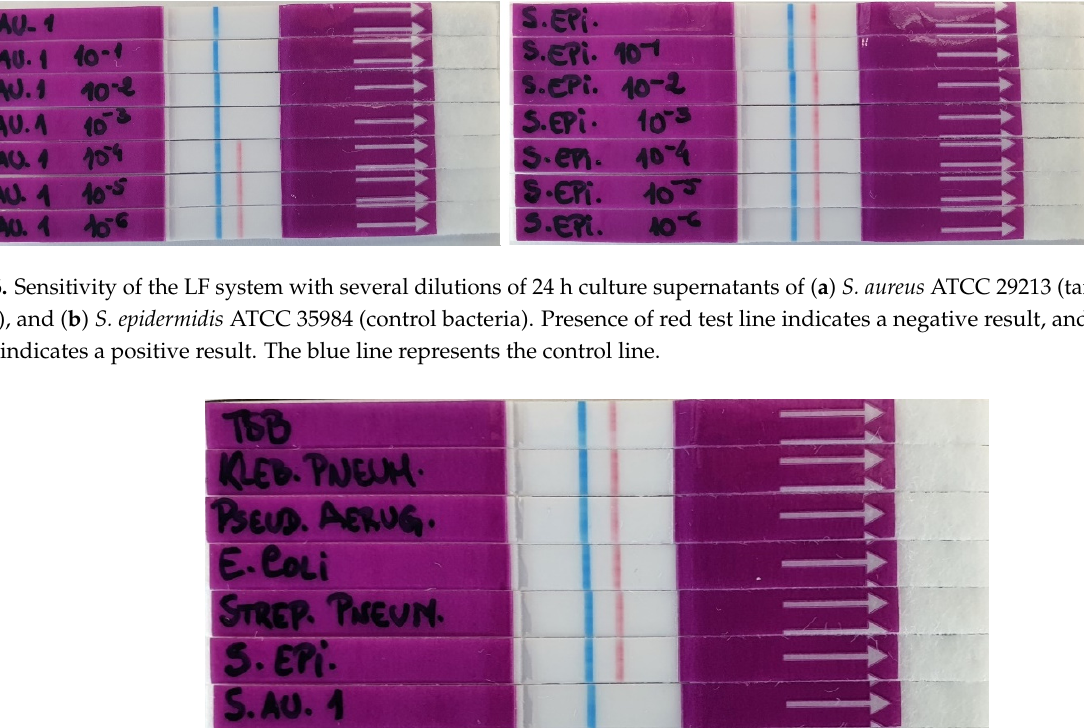
Figure 6. Sensitivity of the LF system with several dilutions of 24 h culture supernatants of ( a ) S. aureus ATCC 29213 (target bacteria), and ( b ) S. epidermidis ATCC 35984 (control bacteria). Presence of red test line indicates a negative result, and no red line indicates a positive result. The blue line represents the control line.